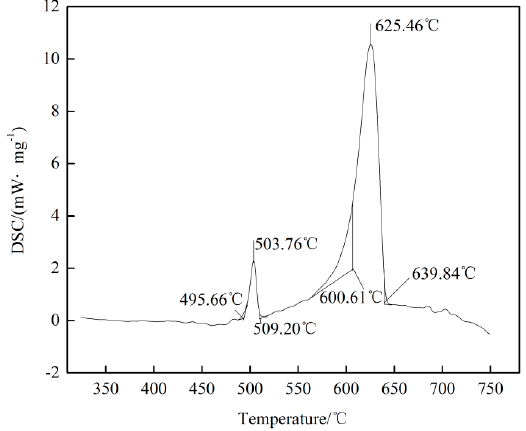
Figure 12. DSC cooling curve of the as-cast Mg-3Y-3.5Sm-2Zn-0.6Zr alloy.